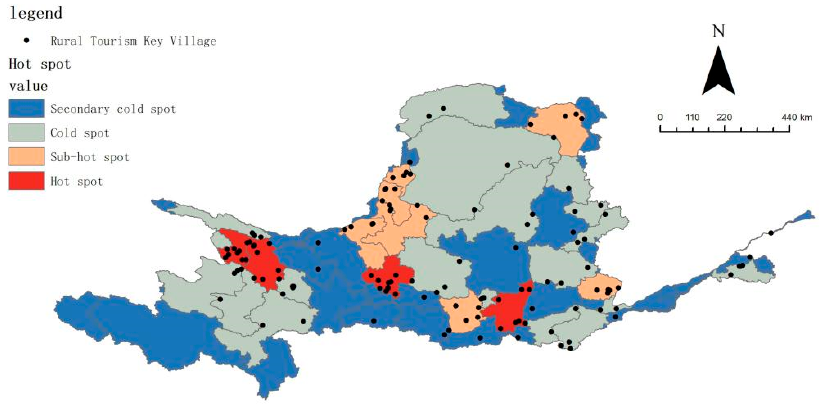
Figure 4. Cold and hot spot map of key rural tourism villages in the Yellow River